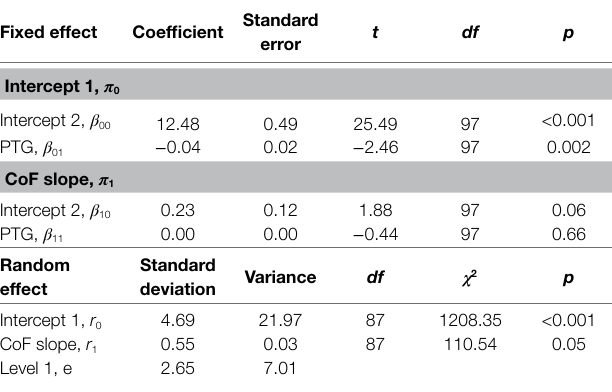
TABLE 3 | The moderating effect of PTG in the effect of COVID-19-related restrictions and concerns on depression.